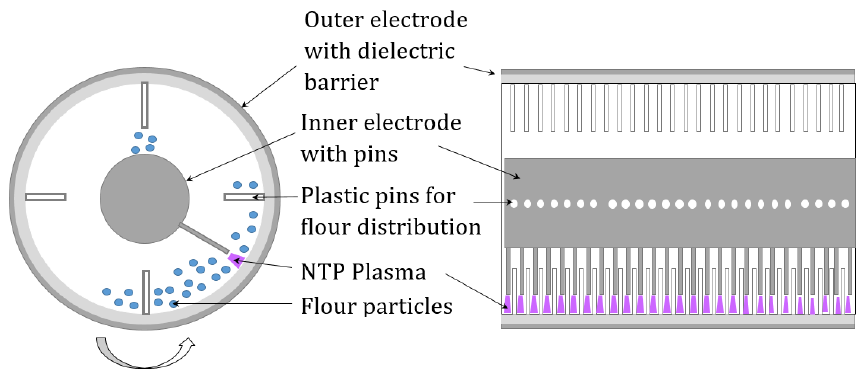
Figure 2. Test reactor for dielectric barrier discharge (DBD) plasma flour interaction.